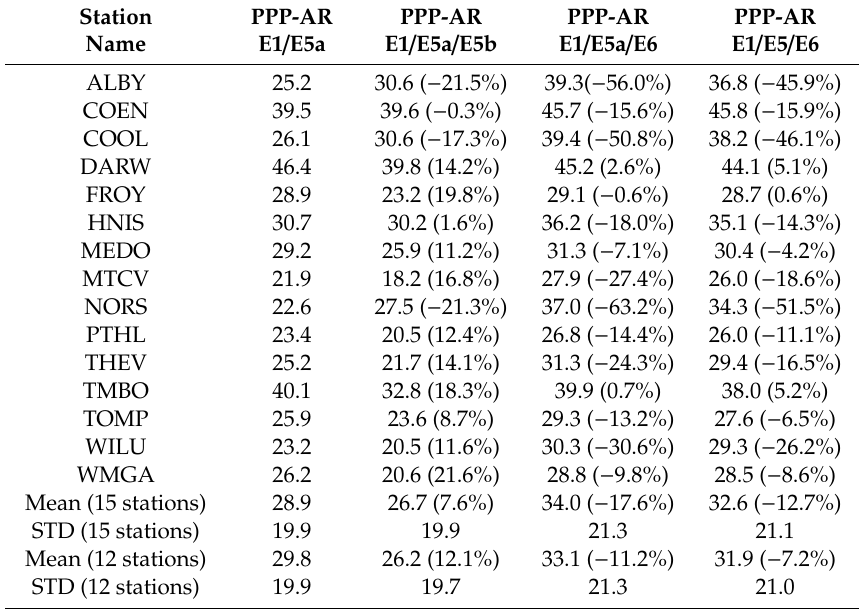
Table 4. Mean convergence time (minutes) of dual-frequency (E1 / E5a) and triple-frequency (E1 / E5a / E5b, E1 / E5a / E6, and E1 / E5 / E6) PPP-AR with the o ffi cial GPS receiver antenna corrections for solutions with respect to each station. The reduction rate of the convergence time of triple-frequency PPP-AR relative to dual-frequency PPP-AR is shown in